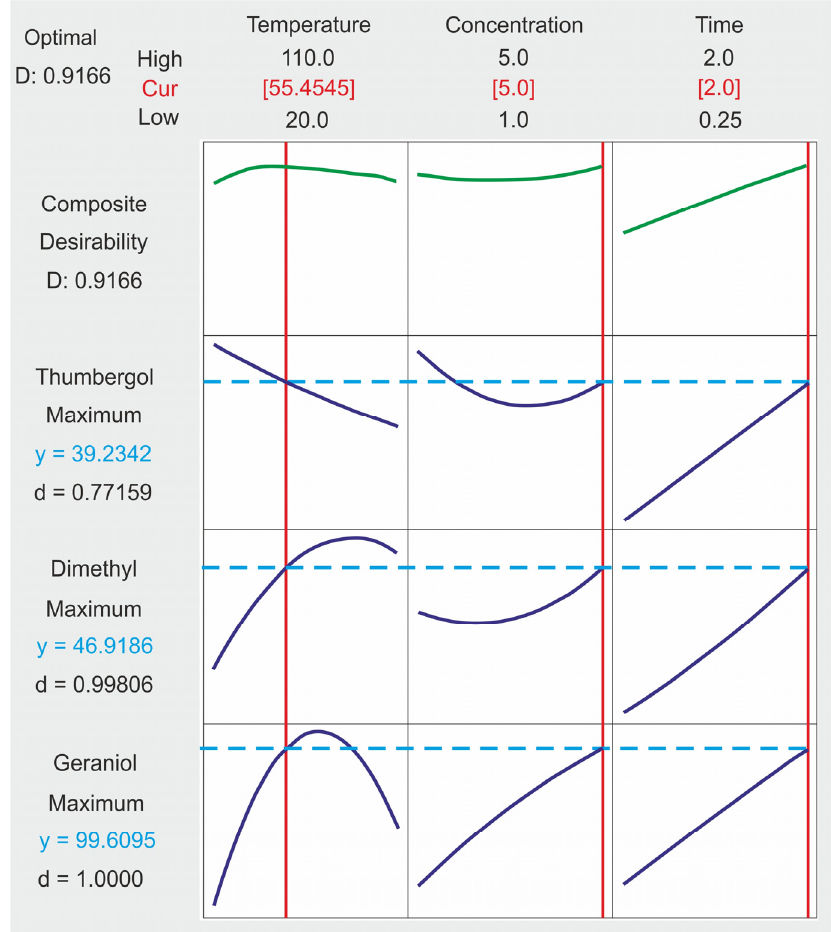
Figure 9. Control factors at optimal levels for each output factor.